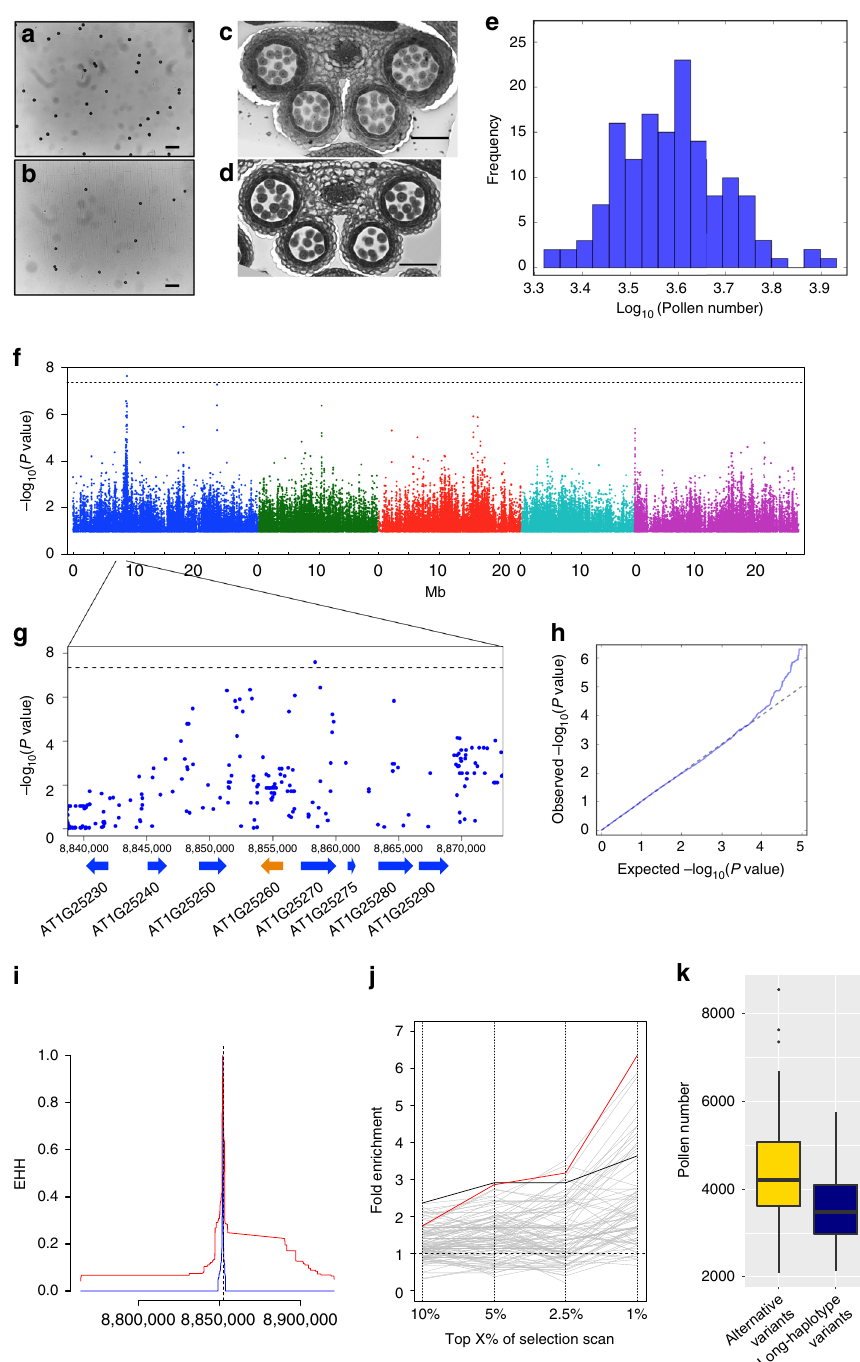
Fig. 1 Genome-wide association study of pollen number variation in Arabidopsis thaliana . a , b Pollen grains of higher pollen number accession Bor-4 ( a ) and lower pollen number accession Mz-0 ( b ) mounted on glass slides for counting 52 . Scale bars = 100 μ m. c , d Histological sections of Bor-4 ( c ) and Mz-0 ( d ) stamens. At least three independent observations showed similar results ( a – d ). Scale bars = 50 μ m. e Distribution of pollen number variation across 144 natural accessions. f Manhattan plot of the genome-wide association study (GWAS). g Closer view of the region around the signi fi cant GWAS peak on chromosome 1 with gene models and coordinates. f , g SNPs with minor allele frequency > 0.15 are shown; horizontal dashed lines indicate the nominal P < 0.05 threshold after Bonferroni correction. h Quantile – quantile plot of the GWAS. i Extended haplotype homozygosity (EHH) detected in the RDP1 genomic region. Red and blue lines correspond to the long haplotype and alternative variants, respectively. j Signatures of selection at pollen number- associated loci. Each line indicates a phenotype (red: pollen number, black: ovule number, gray: 107 phenotypes 19 ). The x axis quanti fi es the extreme tails of the integrated haplotype score (iHS) statistic. The pollen and ovule GWAS show signi fi cant enrichment (permutation test, P < 0.05 cutoff for all iHS statistical tails; Supplementary Fig. 3). k Accessions with the long-haplotype variants (de fi ned by SNP 1-8852112) generally showed lower pollen number ( P = 2.152 × 10 – 6 , two-sided t test; population structure-corrected GWAS P = 2.95 × 10 – 6 ). Boxplots show center line: median; box limits: upper and lower quartiles; whiskers: not >1.5 times the interquartile range; dots: outliers. Source data underlying e , j and k are provided as a Source Data fi